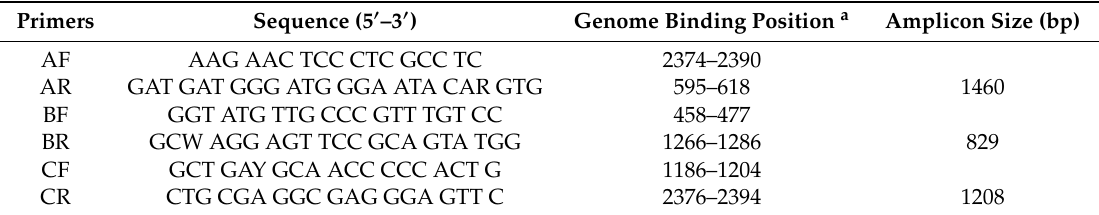
Table 2. Primers for full-length genome HBV